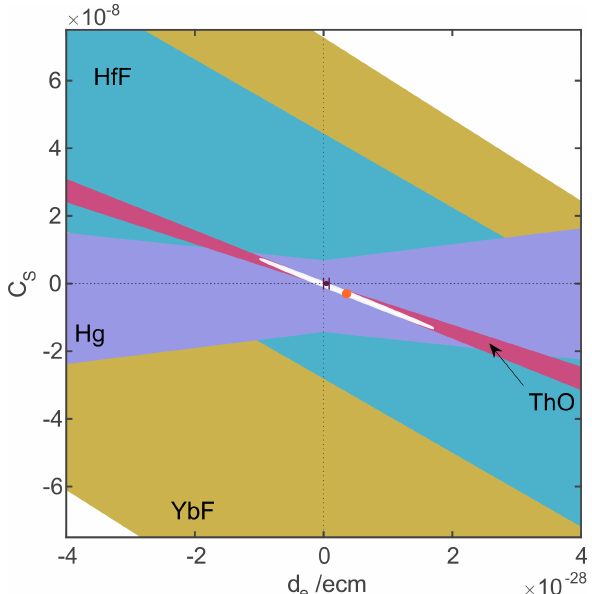
Figure 4. Fit of the current best results from the paramagnetic systems including 199 Hg in order to break degeneracy. The plot is an update of a similar one in [43], using the latest results and relations of [20]. The colored bands denote the results from the di ff erent systems, the orange point is the best fit value with a 1- sigma confidence ellipse (white), while the data point with error bars indicates the latest result from the ACME collaboration[13] on the eEDM assuming only the intrinsic electron EDM as CPV